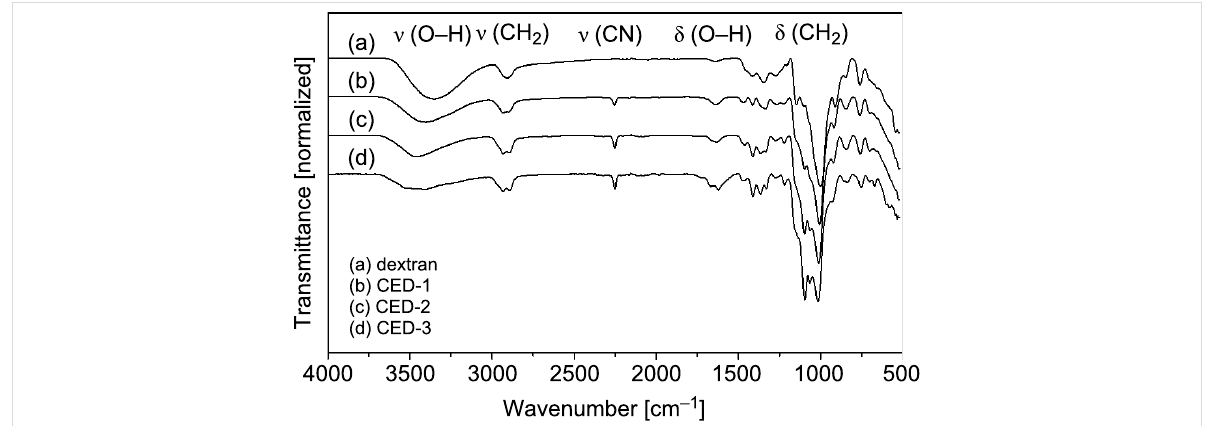
Figure 2: ATR–IR spectra of (a) dextran, 6 kDa, and cyanoethyldextrans (b–d) CED-1–3.